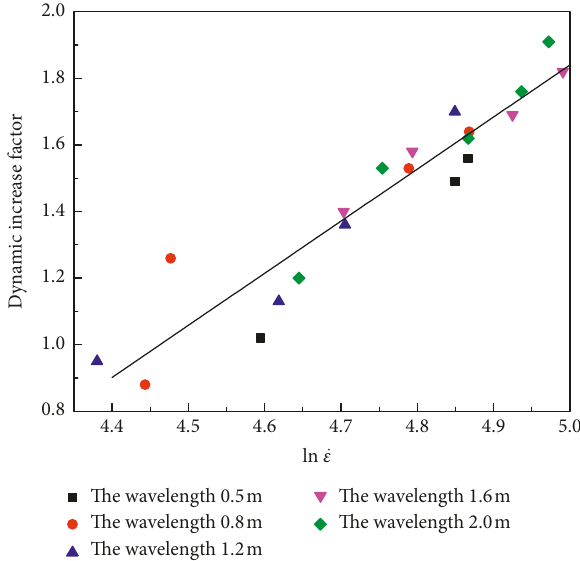
Figure 3: Relationship between dynamic increase factor and natural logarithm of strain rate.